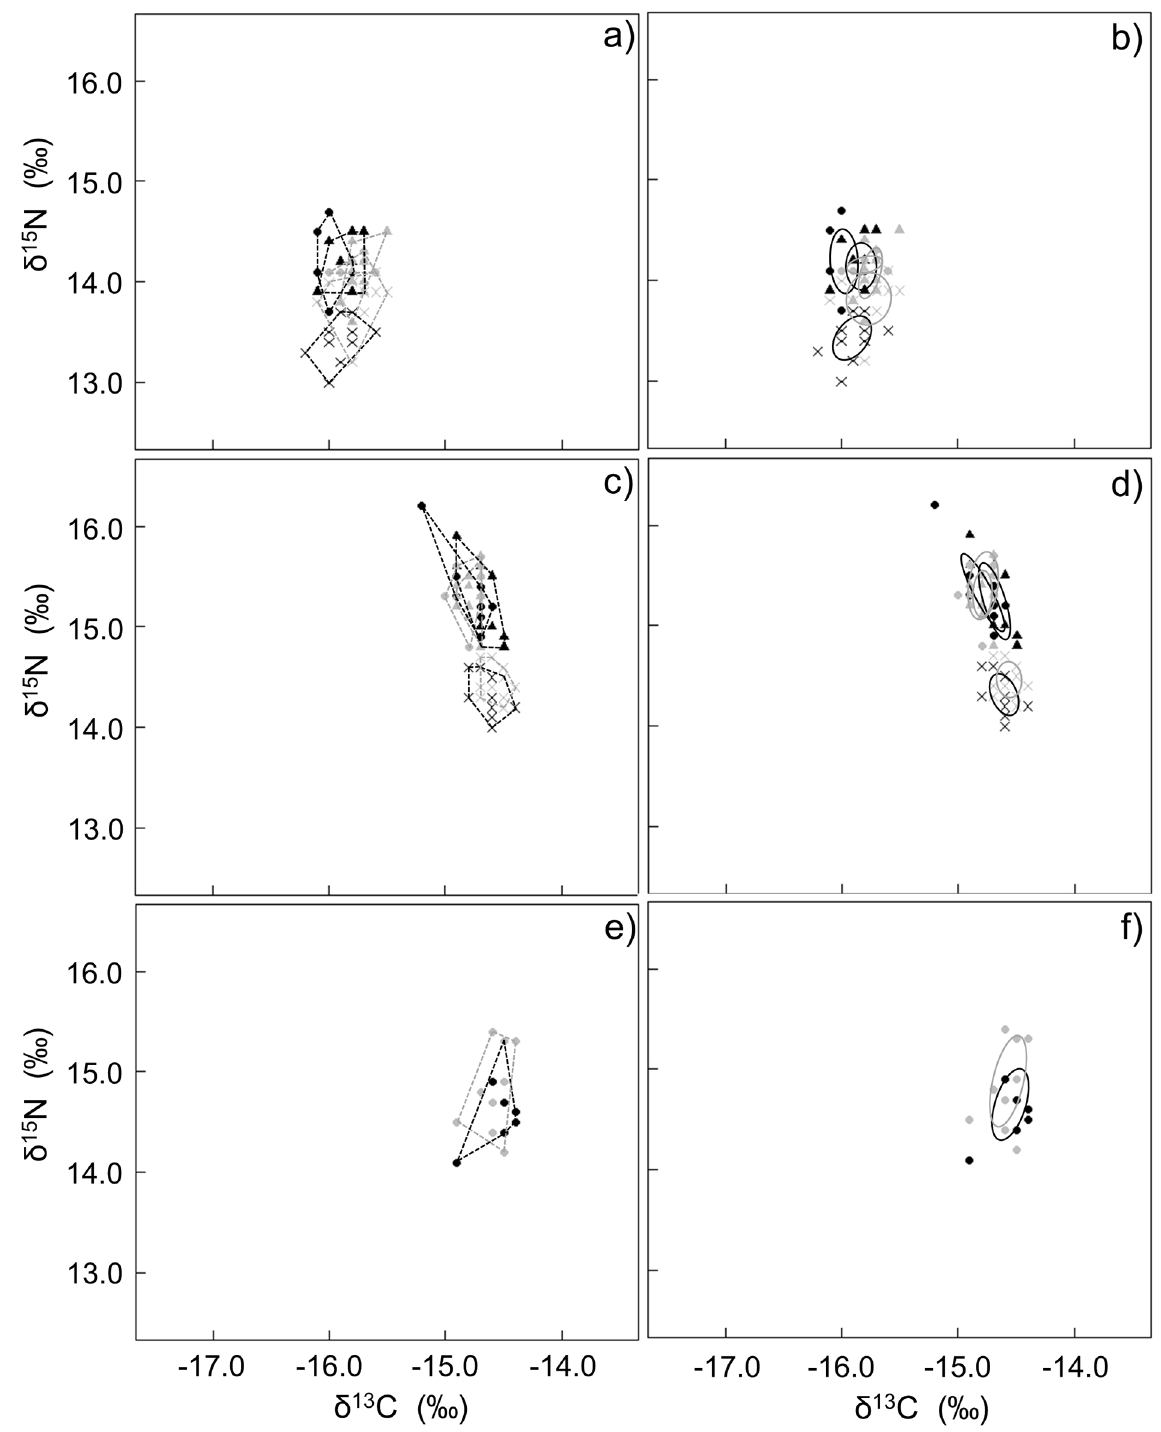
Fig 3. Spatial variation in the isotopic space depicting niche areas for African penguins blood (a, b), feathers (c, d) and egg membrane (e, f) using convex hull areas (a, c, e; [31]) and standard ellipse areas corrected for small sample size (b, d, f; [30]). Females (circles), males (triangles) and blues (crosses) sampled on Bird and St Croix islands are represented in black and grey, respectively.